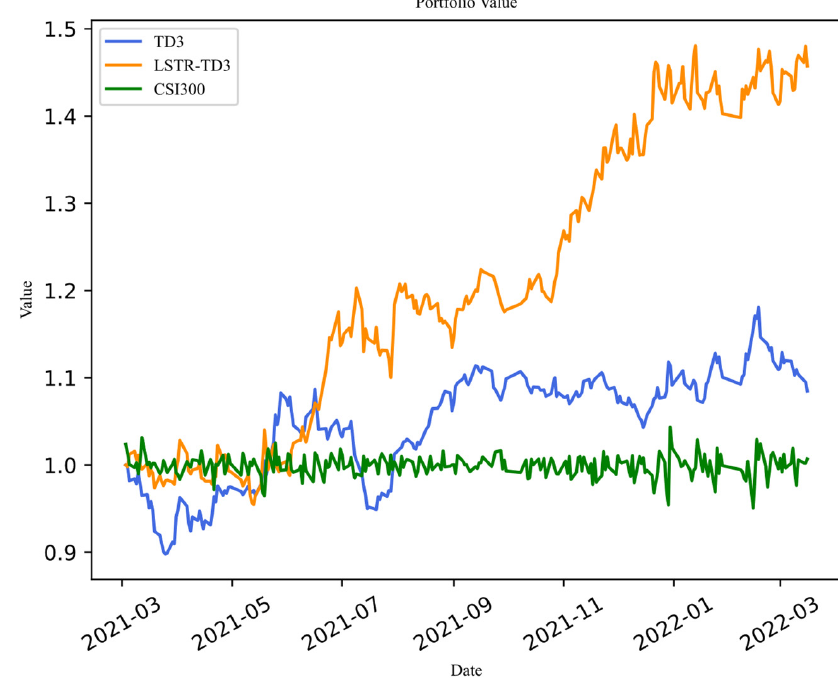
Figure 10. Portfolio value of Portfolio 1.